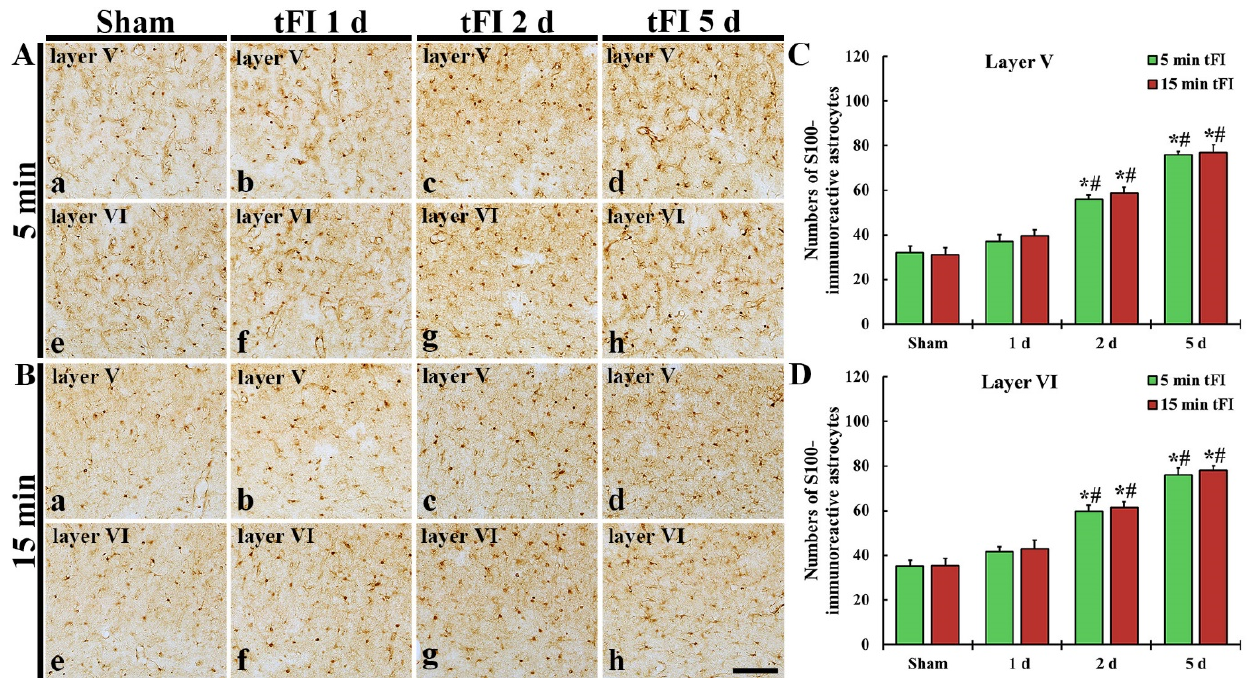
Figure 6. ( A , B ) S100 immunohistochemistry in layers V and VI of the motor cortex in the mild sham ( Aa , Ae ), mild tFI ( Ab – Ad , Af – Ah ), severe sham ( Ba , Be ), and severe tFI ( Bb – Bd , Bf – Bh ) groups at one day ( Ab , Af , Bb , Bf ), two days ( Ac , Ag , Bc , Bg ) and five days ( Ad , Ah , Bd , Bh ) after tFI. S100-astrocytes are significantly increased in numbers from two days after tFI. Scale bar = 200 μ m. ( C,D ) Mean numbers of S100-astrocytes in layers V and VI ( n = 5 or 7, respectively; * p < 0.05, significantly different from mild or severe sham group, # p < 0.05, and significantly different from corresponding former time group). The bars indicate the means ± SEM.